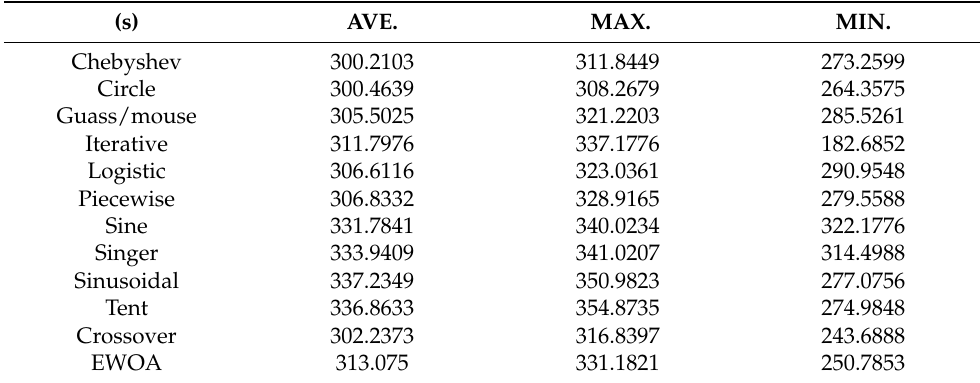
Table 4. Statistical results of the running time obtained by different improved